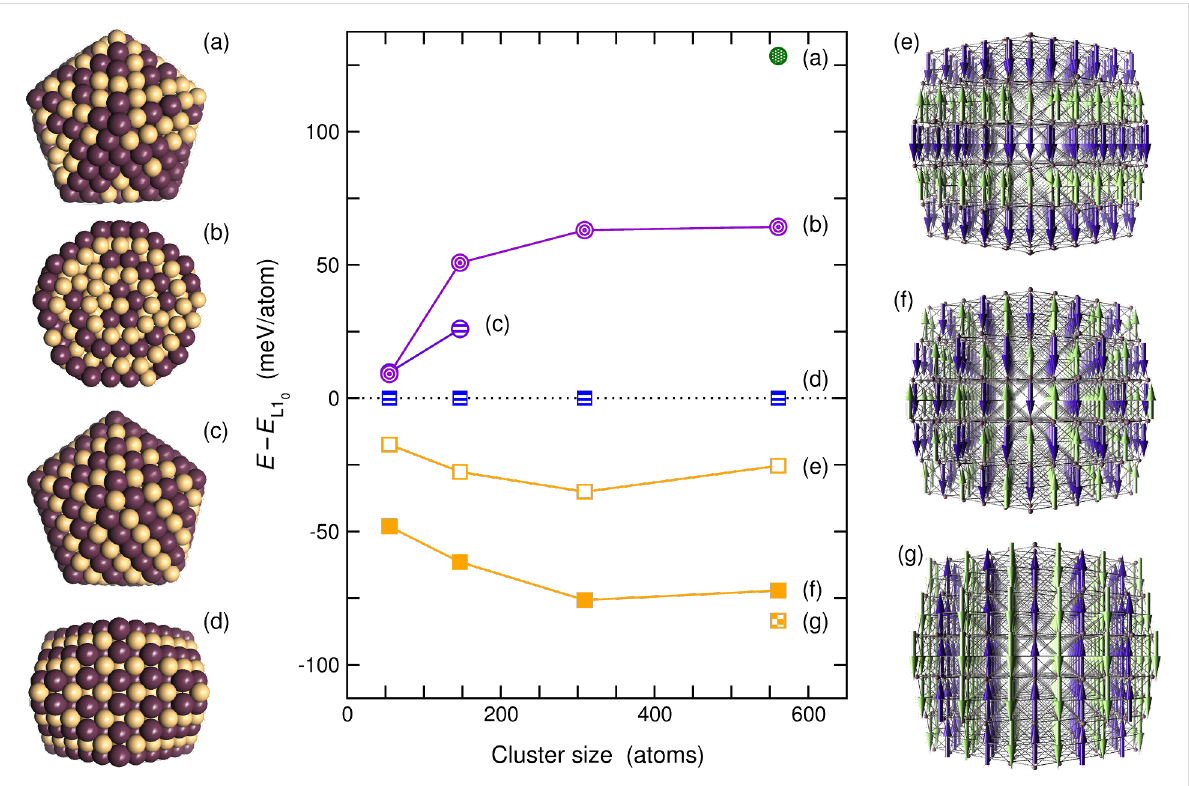
Figure 1: Energies of Mn–Pt clusters of various morphologies and sizes. The energy reference is marked by the L1 0 cuboctahedron. The letters in parentheses refer to the corresponding structures which are depicted at both sides of the diagram (only the structures with N = 561 atoms are shown). These are: (a) the disordered icosahedron, (b) the onion-ring icosahedron in cross section, (c) an ordered icosahedron, (d) the ferromagnetic L1 0 cuboctahedron, (e) an antiferromagnetic cuboctahedron with layered spin arrangement perpendicular to the c axis, (f) a staggered antiferromagnetic cuboctahedron and (g) an antiferromagnetic cuboctahedron with spin arrangement layered parallel to the c axis. Orange spheres (or, respectively, blue and green arrows) refer to Mn atoms, purple spheres to Pt. Colors and symbols: Shaded green circles denote disordered icosahedra (a). Triply nested circles refer to icosahedra with shell-wise ordering tendencies (b), hatched blue to violet symbols the ordered structures (c) and (d). Orange symbols denote L1 0 cuboctahedra with antiferromagnetic ordering of the 3d moments (e)–(g). The lines are only guides for the